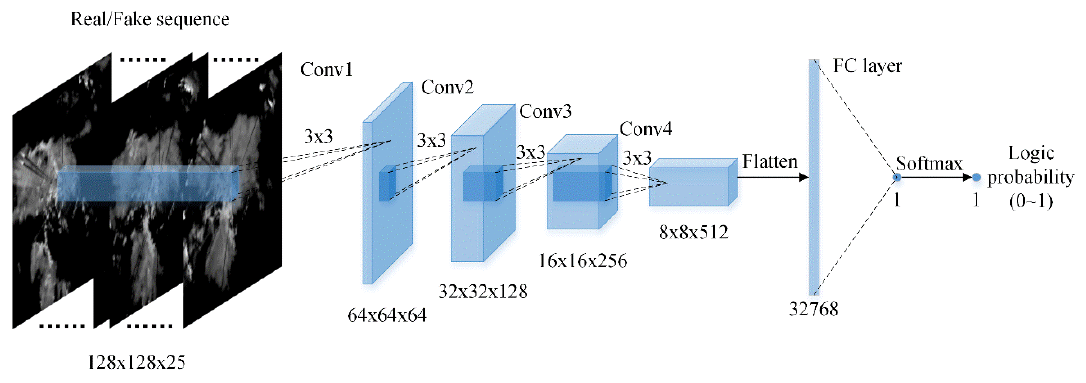
Figure 4. The schematic of the discriminator.